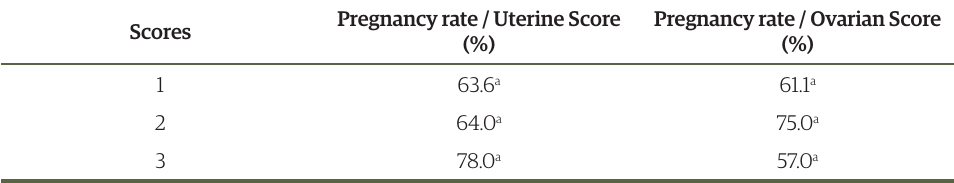
Table 1. Effect of uterine and ovarian score on the pregnancy rate of Girolando heifers submitted to Timed Artificial